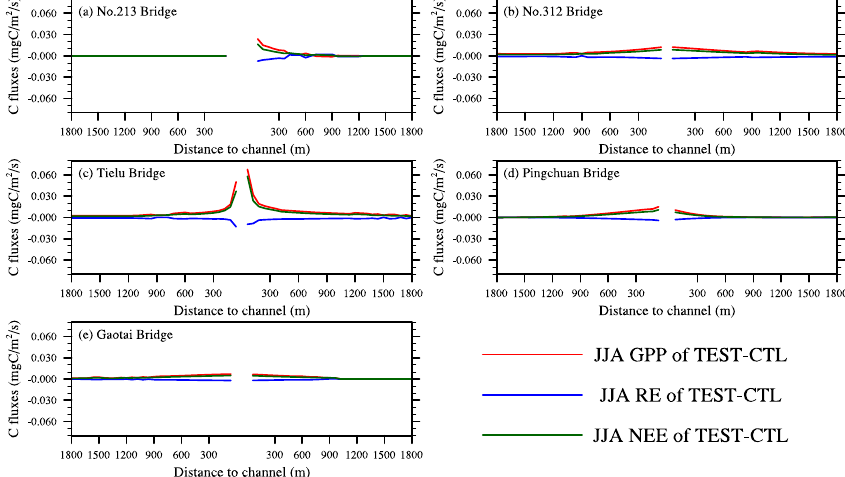
Figure 15. Differences between gross primary productivity, respiration efficiency and net ecosystem exchange predicted by TEST and CTL simulations during summer along the five sections at (a) 213 Bridge, (b) 312 Bridge, (c) Tielu Bridge, (d) Pingchuan Bridge, and (e) Gaotai Bridge. The discontinuous parts of the curves represent the river areas.